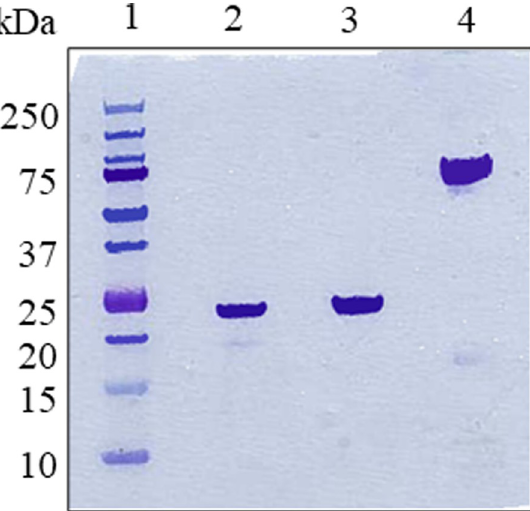
Fig 2. SDS-PAGE analysis. MW markers (lane 1), purified starting material (DH-CNTF, lanes 2 and 3) and PEG-DH-CNTF (lanes 4).